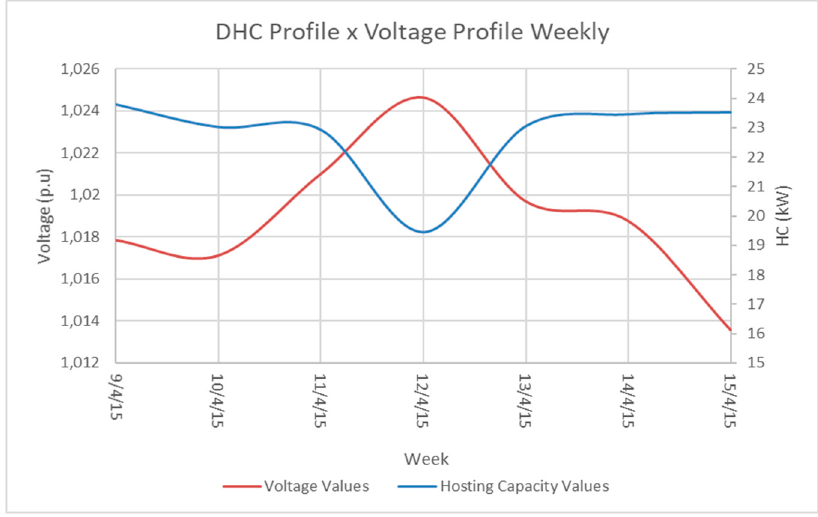
Figure 17. The DHC(t) profile versus the voltage profile and its meaning.